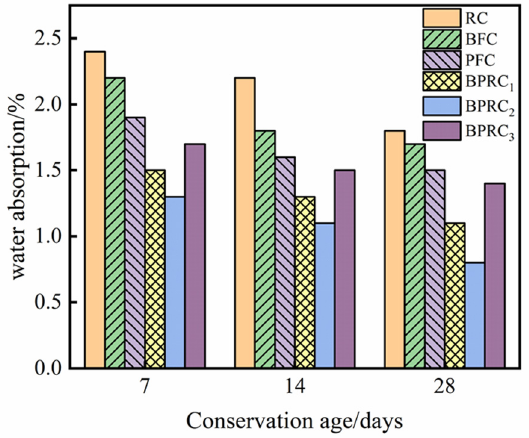
Figure 3. Water absorption of each group of specimens.